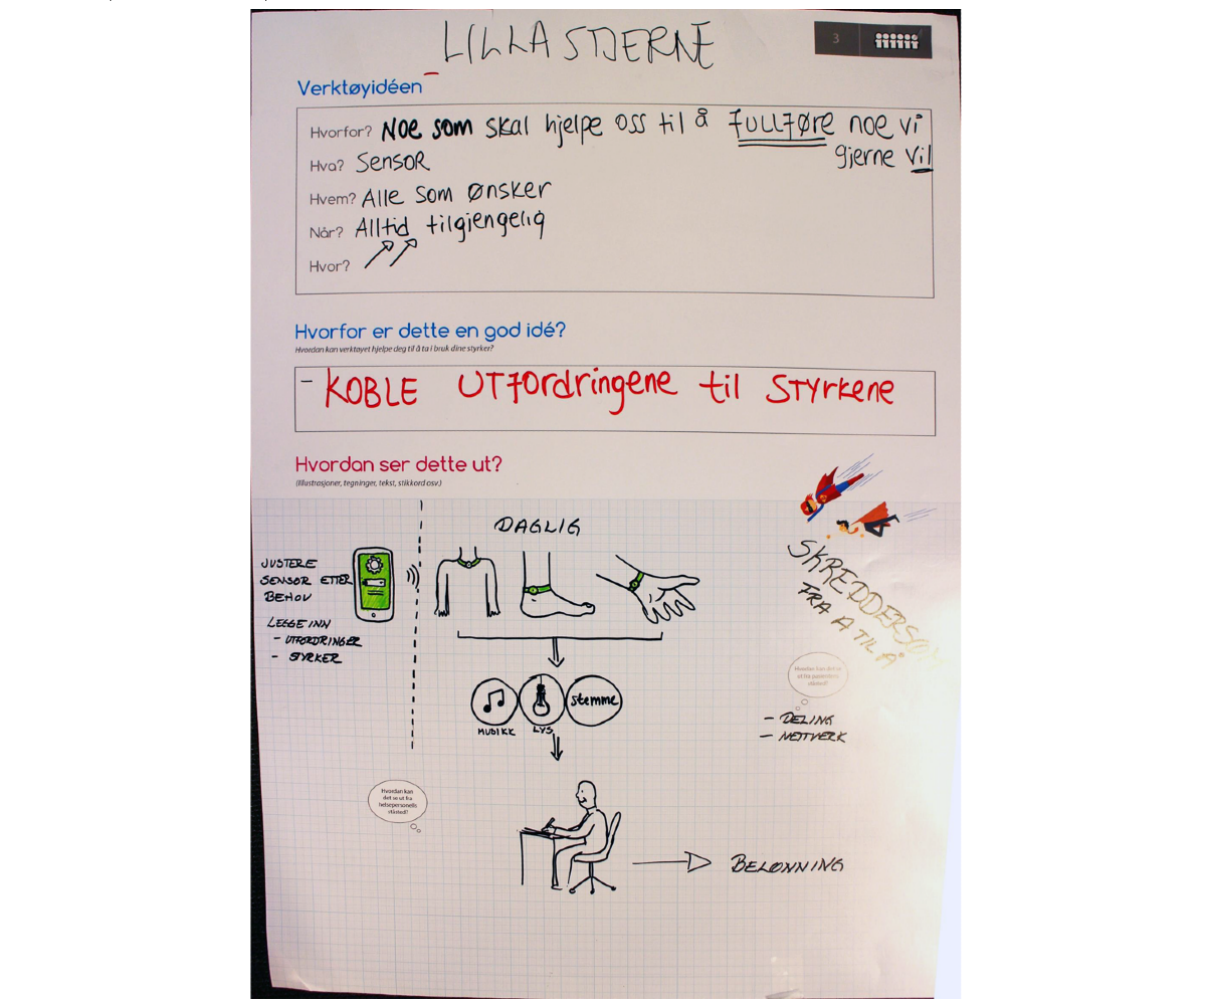
Figure 3. Example of